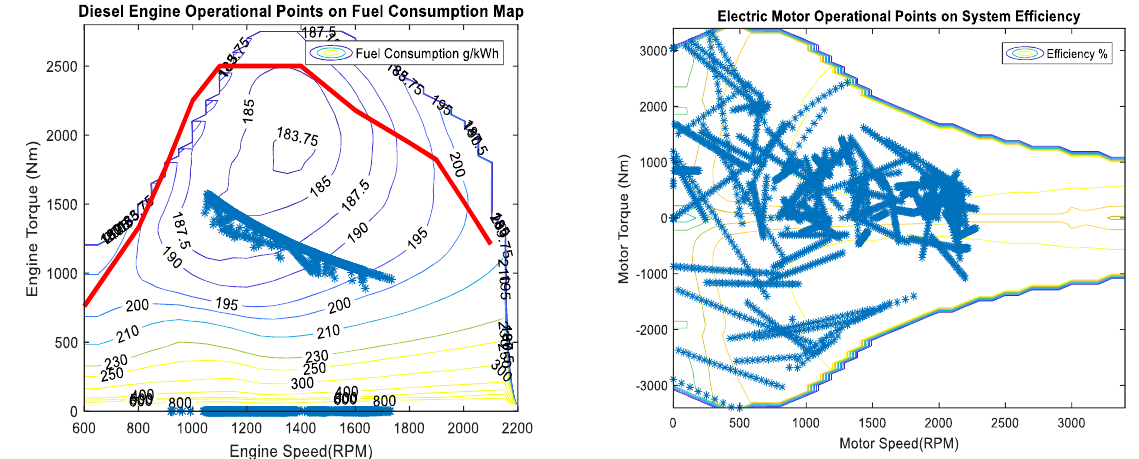
Figure 13. Operational points on diesel engine and electric motor during drive cycle. * Operational point.